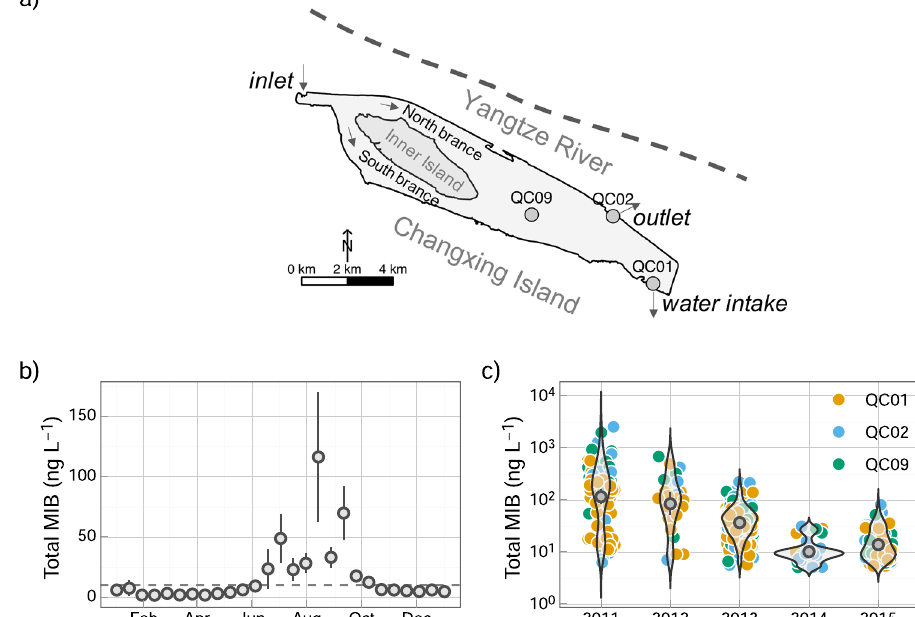
Fig. 1 Description of study sites and MIB dynamics. a Sampling sites in QCS Reservoir. b Seasonal dynamics of MIB concentration from 2011 to 2015. c Annual dynamics of MIB concentration in July to September from 2011 to